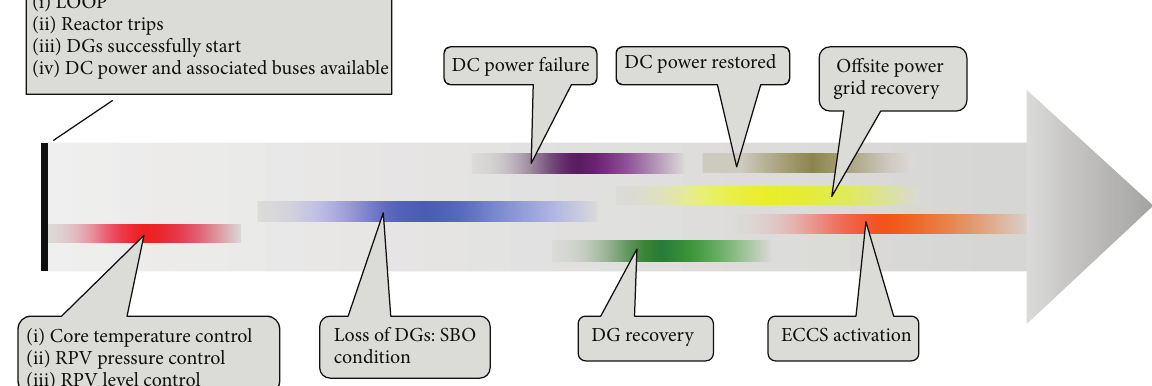
Figure 8: Sequence of events for the SBO scenario